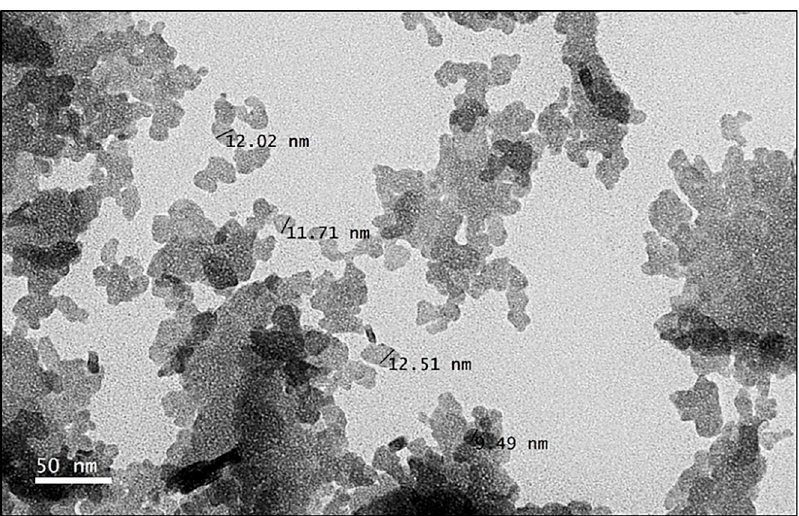
Figure 4. Transmission electron microscopy (TEM) image of Citral-loaded self nano-emulsifying drug